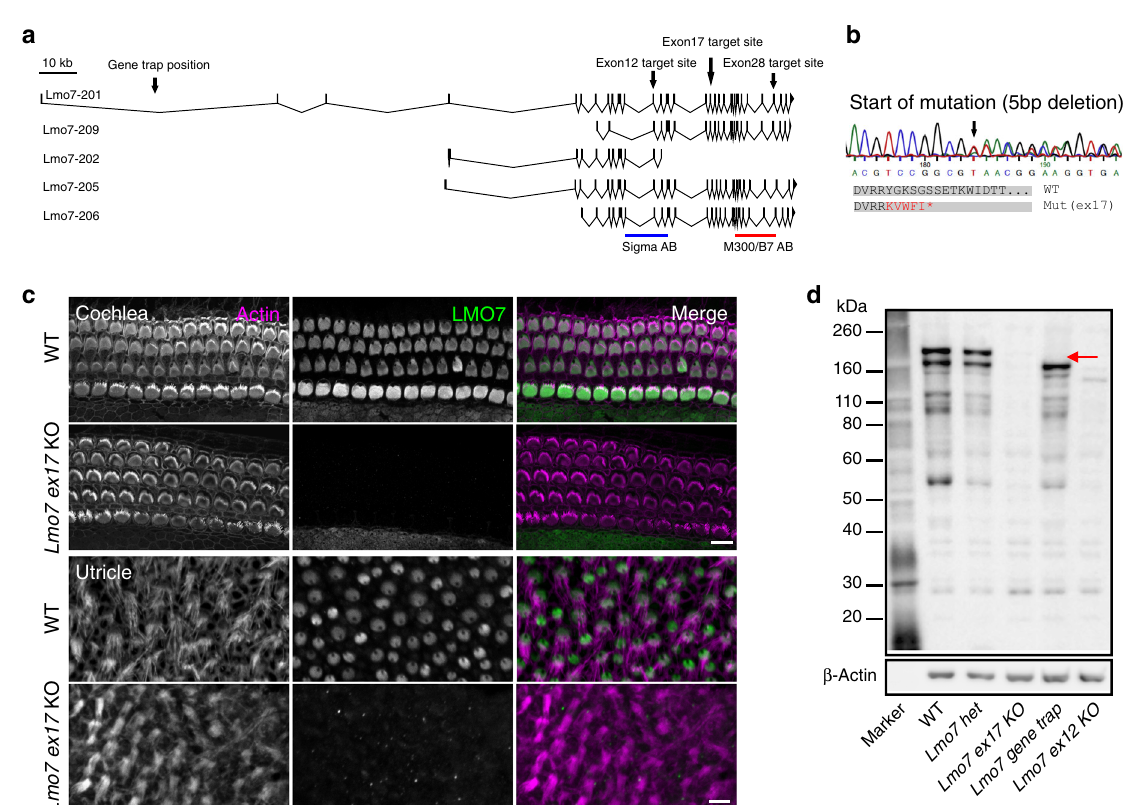
Fig. 3 Generation of LMO7-de fi cient mice. a Genomic structures of mouse Lmo7 isoforms from Ensembl (GRCm38.p5). Exons and 5 ′ untranslated regions are indicated by black boxes, 3 ′ untranslated regions are indicated by black triangles. The locations of the gene trap and three CRISPR-mediated targeting sites are shown with arrows. The epitope regions of antibodies used in this study are indicated in blue (Sigma AB) and red (Santa Cruz M-300 and B-7). b Sanger sequencing result of edited locus demonstrates successful genome editing, resulting in a 5 bp deletion in exon 17 which creates a premature stop codon as shown in grey shading. c LMO7 immunolabeling in WT and Lmo7 exon17 KO mice in P4 cochlea and utricle. LMO7 is in green, and F-actin in magenta. LMO7 immunoreactivity is abolished in KO cochlear and vestibular hair cells. d Comparative immunoblot of WT, Lmo7 exon17 Het , Lmo7 exon17 KO, Lmo7 gene trap and Lmo7 exon12 KO from P4 inner ear lysate, indicating loss of LMO7 expression in Lmo7 exon17 lysate. The gene trap strategy only abolished the longest isoform, indicating by red arrow. The β -actin-speci fi c bands indicate equal